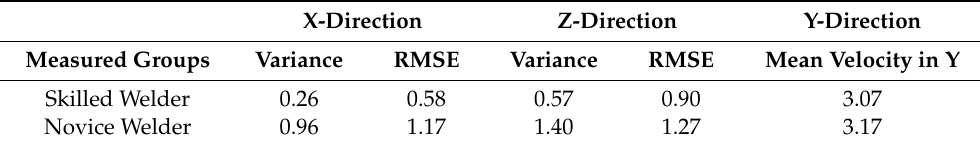
( b ) Figure 8. Boxplots of quantitative measures in the X and Z directions for variance ( a ) and RMSE ( b ) of the users’ torch hand motions for both professional and unskilled welders in the onsite welding experiment. The special symbols (circles and asterisks (*)) are outliers in the data, representing that they are outside of a certain range indicated by the boxes in the box plot. The numbers next to the circles and asterisks indicate which observations in the dataset are outliers.